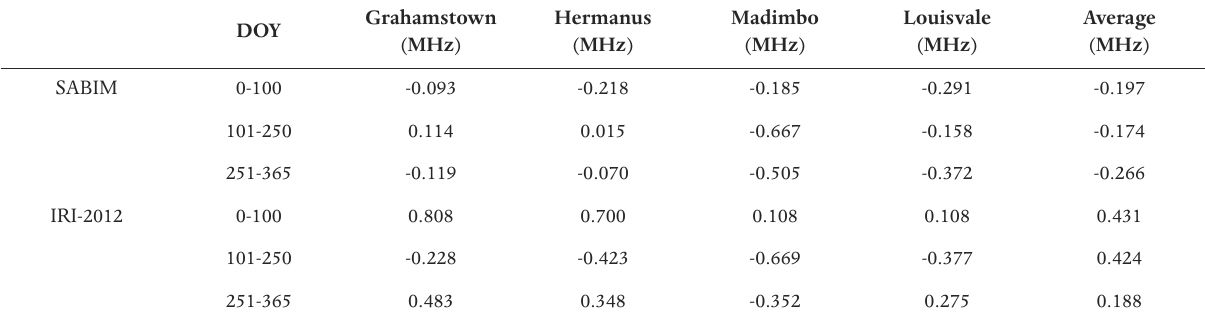
Table 2. Mean difference between measured foF2 values and results from models, SABIM and IRI-2012, based on the DOY in